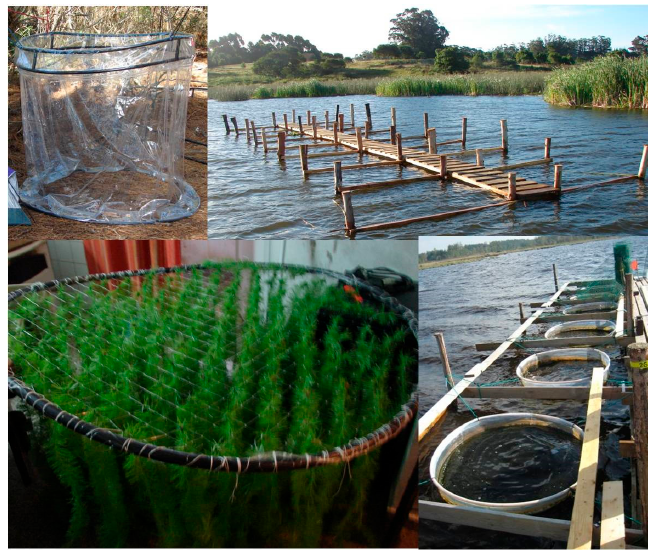
Figure 1. Eight plastic enclosures were fixed to each side of a bridge, and an artificial plant bed was introduced to all enclosures two weeks before sampling to allow periphyton and macroinvertebrates to colonize the plastic structures.